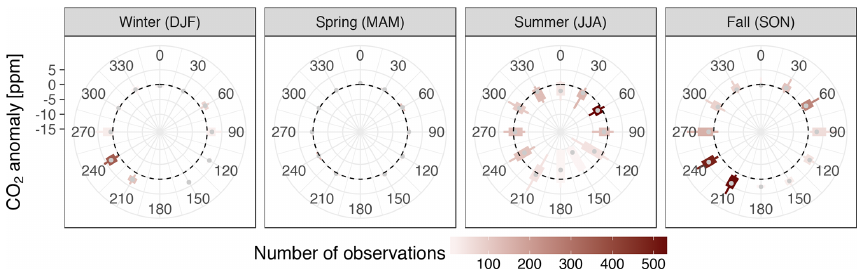
Figure 10. Carbon dioxide anomalies plotted against wind direction. The dashed circle is the baseline (anomaly 0ppm). The (gray) points are the median, boxes the first and third quartile, and whiskers the first and ninth decile. Shown here are data that passed the filters for low wind speeds and temperature inversions (Table 1). The color of boxes and whiskers indicates the number of measurements available in each bin.